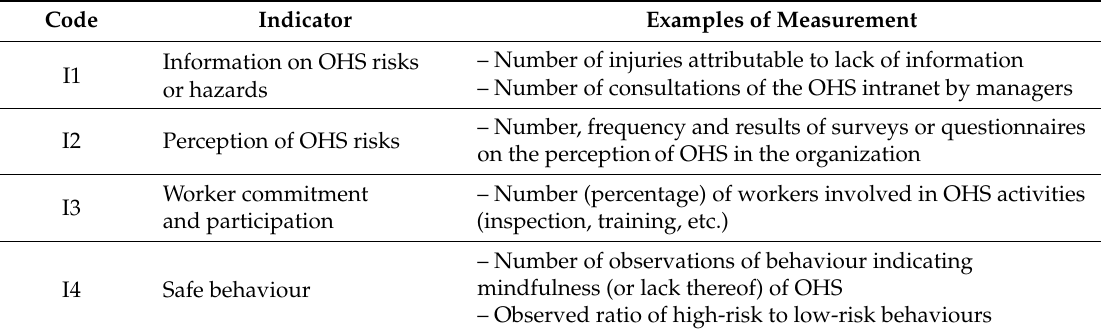
Table 4. Measurable indicators of risk management maturity based on individuals-based